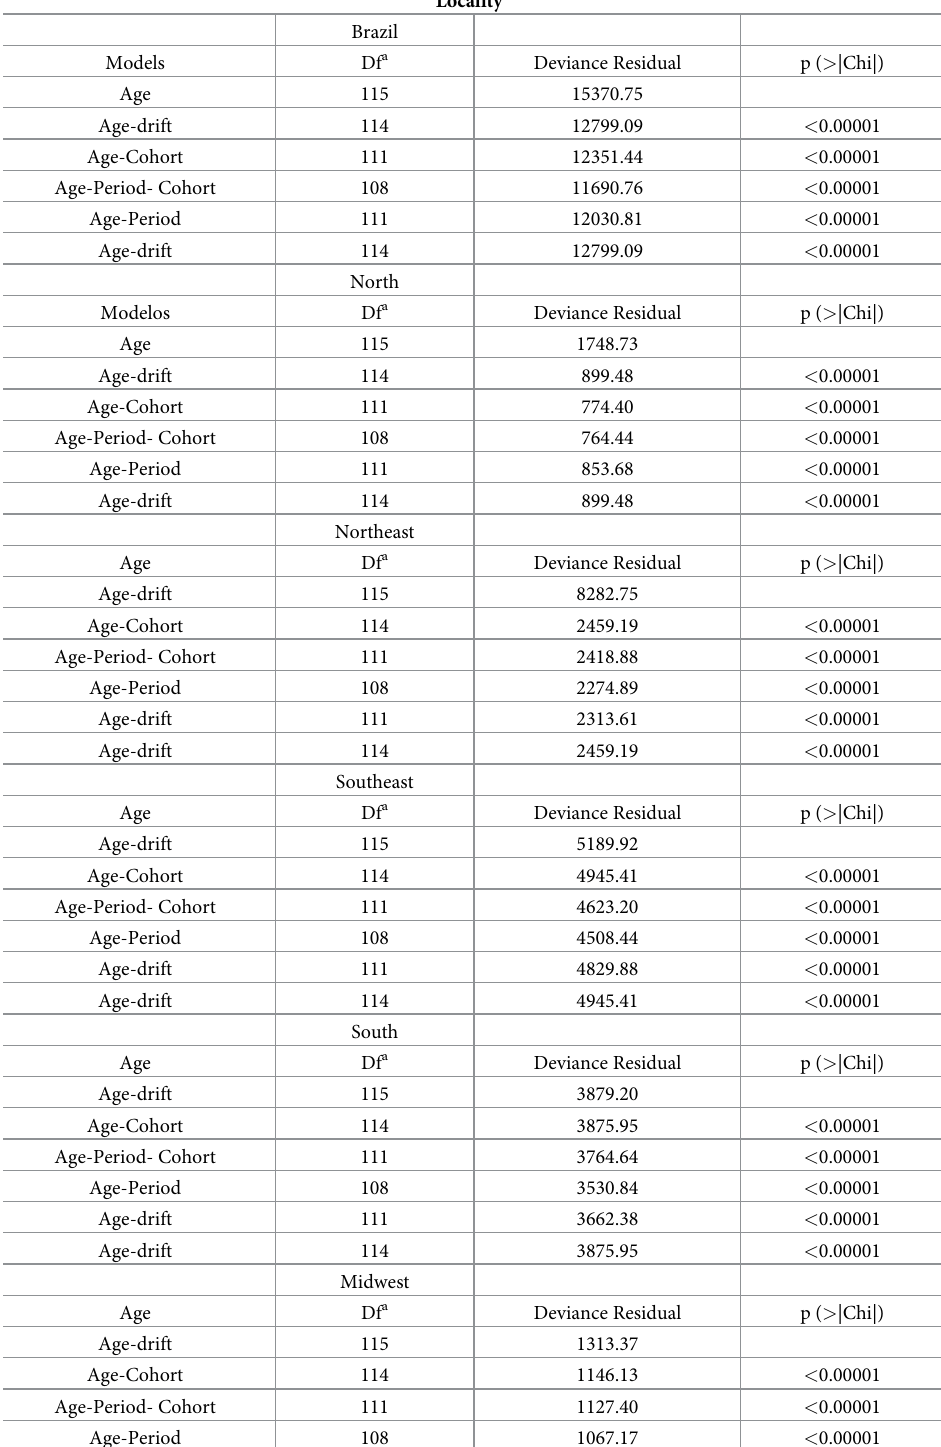
Table 3. Deviance an p-value analysis in sequential construction of age, period, and cohort models for total sui- cides in men, according to Brazil its major regions, from 1980 to 2019.